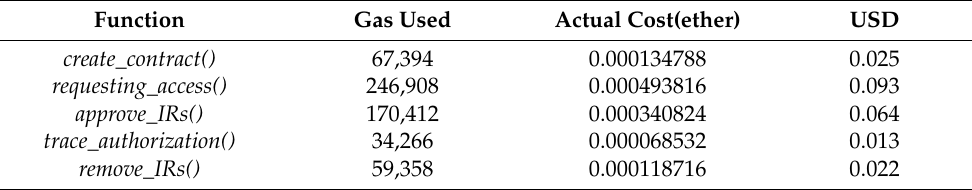
Table 1. PCAC-SC Cost Analysis (gasprice = 2 Gwei, 1 ether = 187 USD). Function Gas